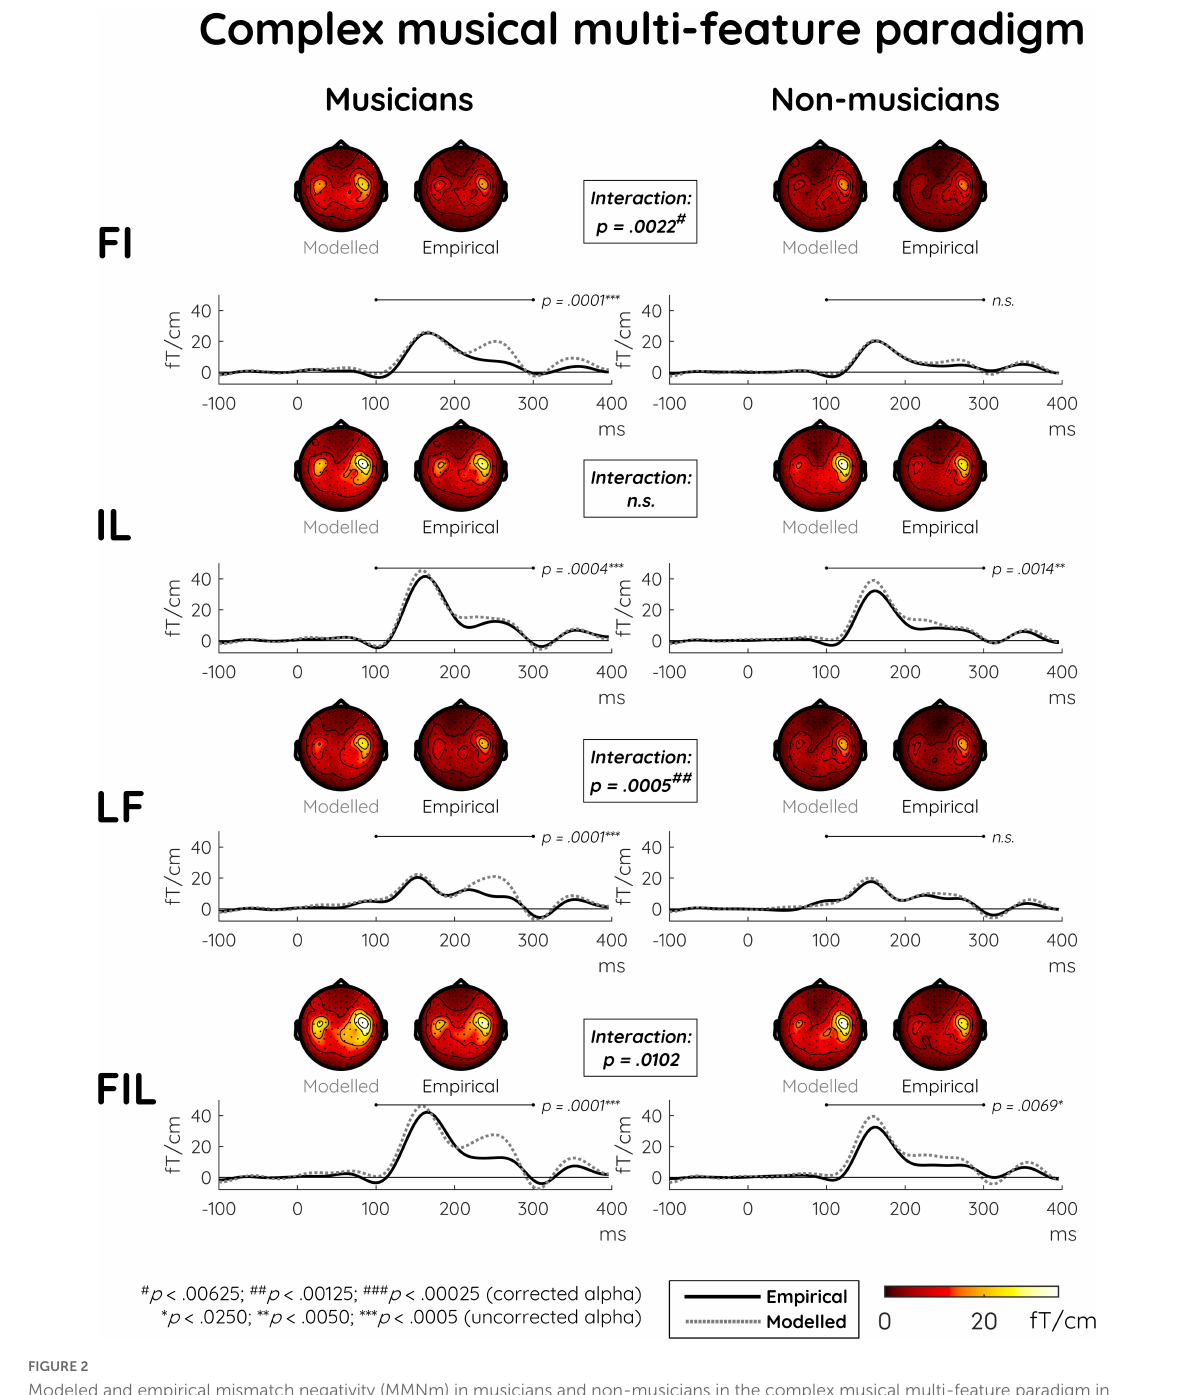
FIGURE2 Modeled and empirical mismatch negativity (MMNm) in musicians and non-musicians in the complex musical multi-feature paradigm in response to deviants differing in either frequency and intensity (FI), intensity and location (IL), location and frequency (LF), or frequency and intensity and location (FIL). Modeled MMNms (dashed gray lines) correspond to the sum of the MMNms to two or three single deviants whereas empirical MMNms (solid black lines) correspond to MMNms obtained for double and triple deviants. Comparing the plots for modeled and empirical MMNms, significantly greater subadditivity was evident in musicians compared to non-musicians specifically in the double deviants involving frequency (i.e., FI and LF). This expertise-by-additivity effect was marginally non-significant for the triple deviant (i.e., FIL). The event-related field (ERF) plots depict the mean of the data from the peak sensor and eight surrounding sensors in each hemisphere [the peak gradiometer pairs were MEG1342 + 1343 (Right) and MEG0242 + 0243 (Left) ]. Low-pass filtering at 20 Hz was applied for visualization purposes only. The topographical distributions depict the 100–300 ms post-stimulus time range for the difference waves between standard and deviant responses, and p -values outside the boxes reflect simple effects of additivity separately for musicians and